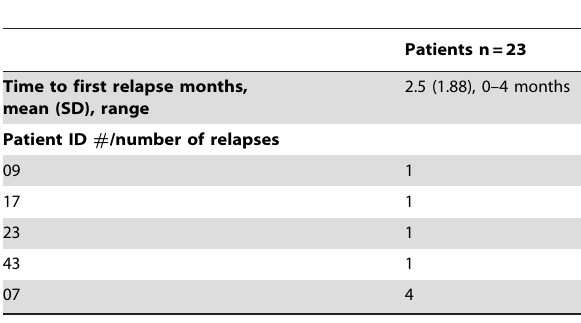
Table 5. Relapses occurring in patients during the